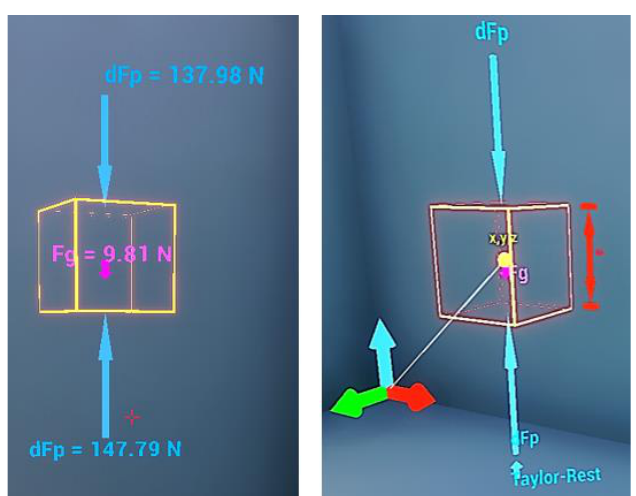
Fig. 5. Cubic differential volume element with acting pressure force on top and bottom side. Left: With numerical values, Right: After